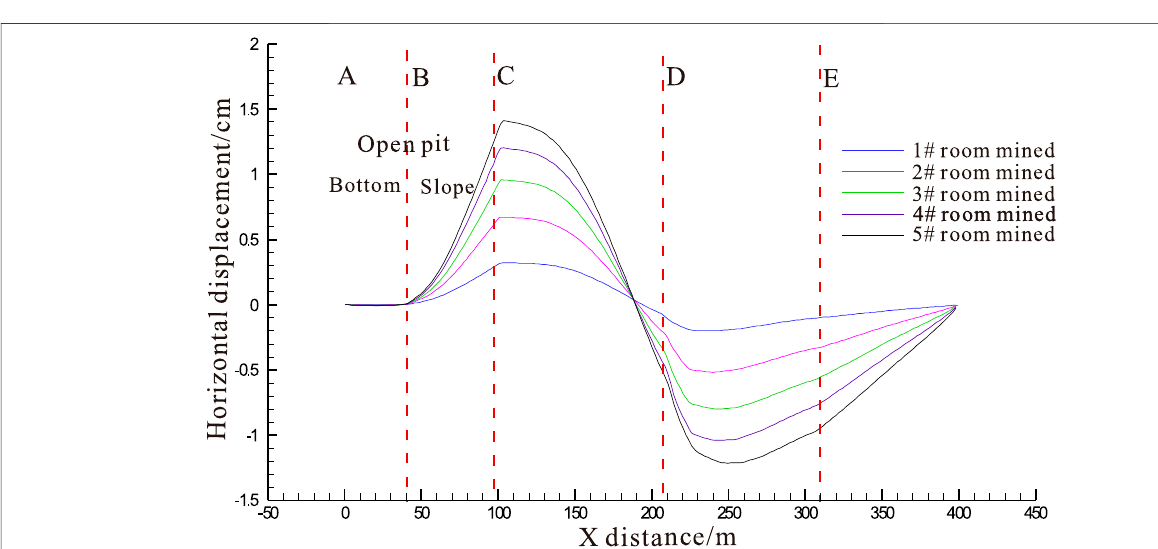
Frontiers in Earth Science |